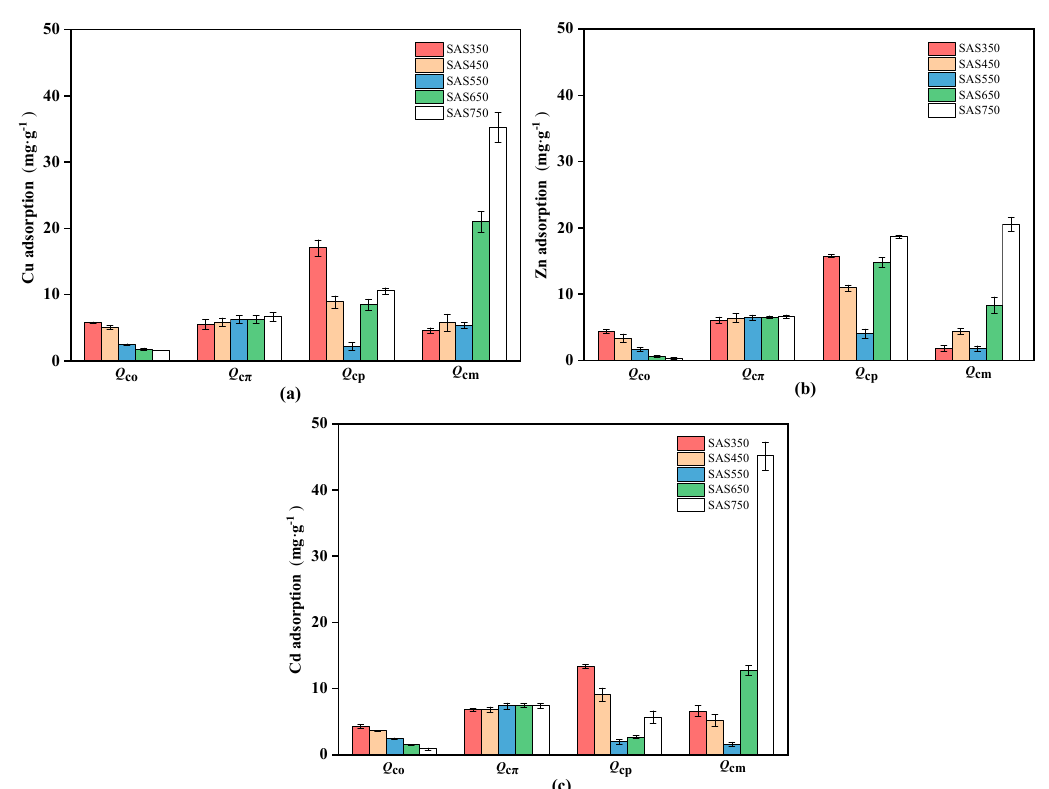
Figure 9. The change of contributions of different adsorption mechanisms with temperature during Cu(II) ( a ), Zn(II) ( b ), and Cd(II) ( c ) adsorption (pH of 5, 24 h, initial concentration of 100 mg·L − 1 and adsorbent dosage of 1 g·L − 1 ).